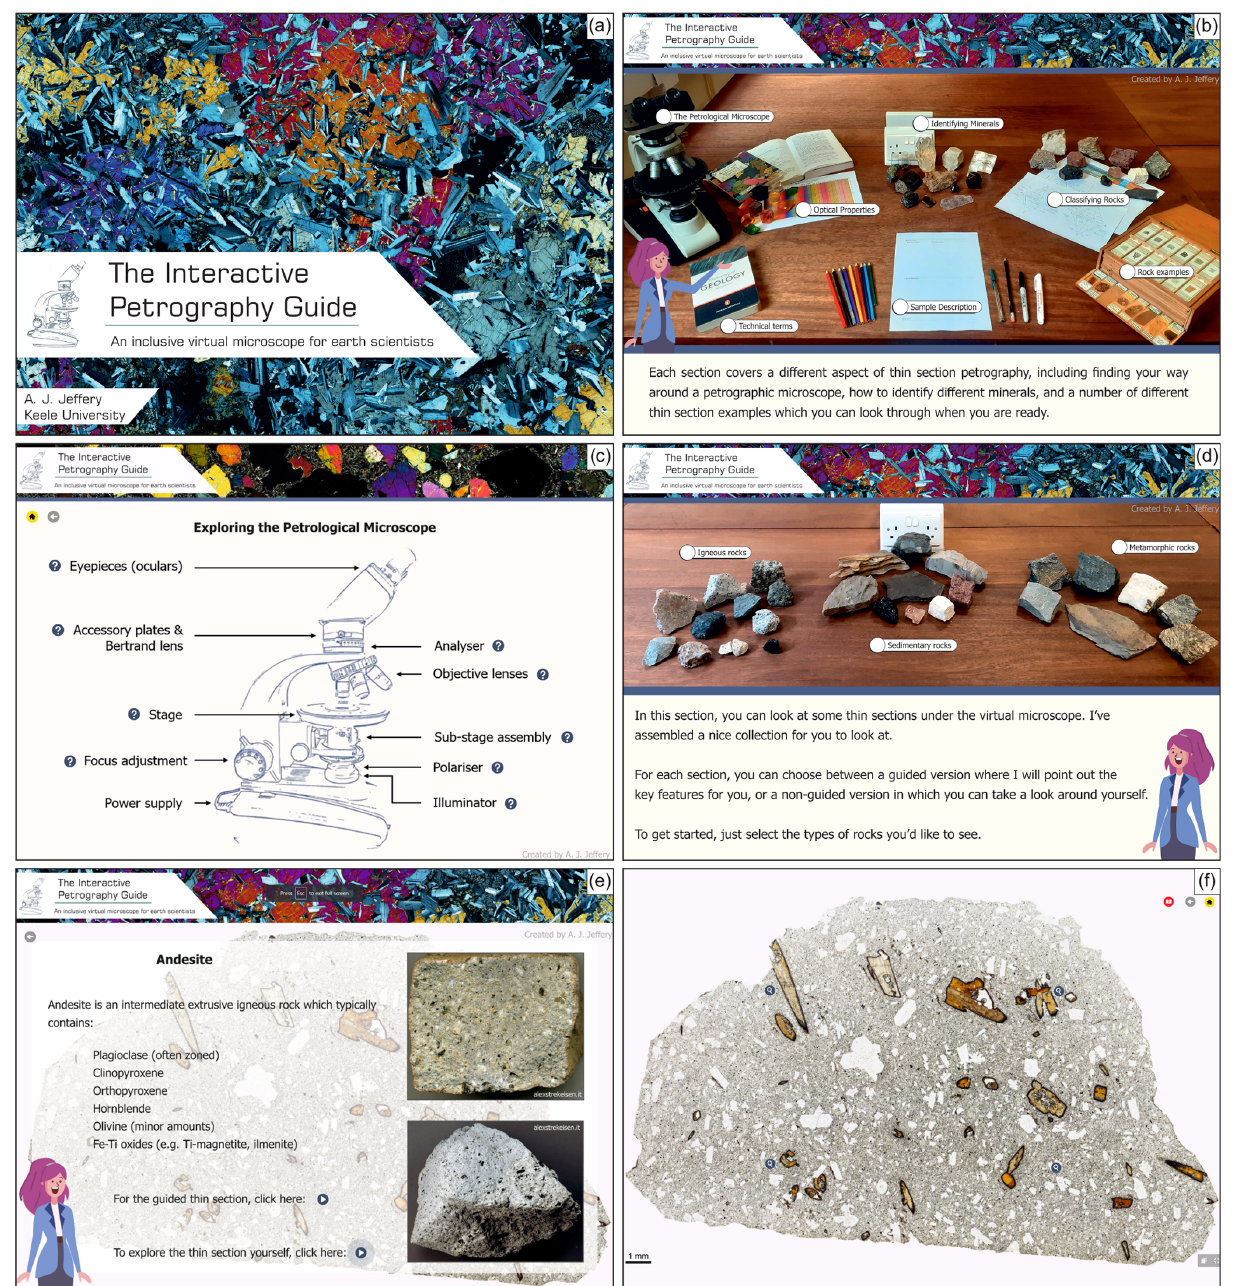
Figure 5. Representative screenshots of a new microscopy resource currently being constructed based on the feedback of this study. Cartoon avatar designed by pikisuperstar/Freepik. (a) Main title screen. (b) Home page with various clickable icons leading to learning materials. (c) Example learning material with various interactive elements. (d) Example submenu in which users can select the type of rock samples to view under the microscope. (e) Example information screen prior to viewing sample under microscope. (f) Example thin-section image with interactive